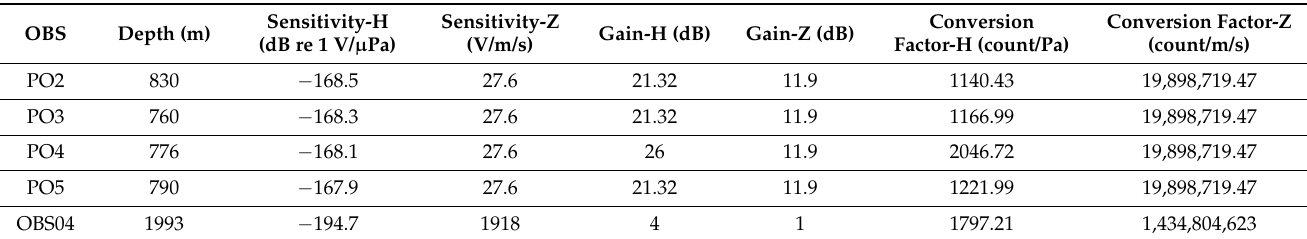
Table 1. Technical specifications of each OBS used in this